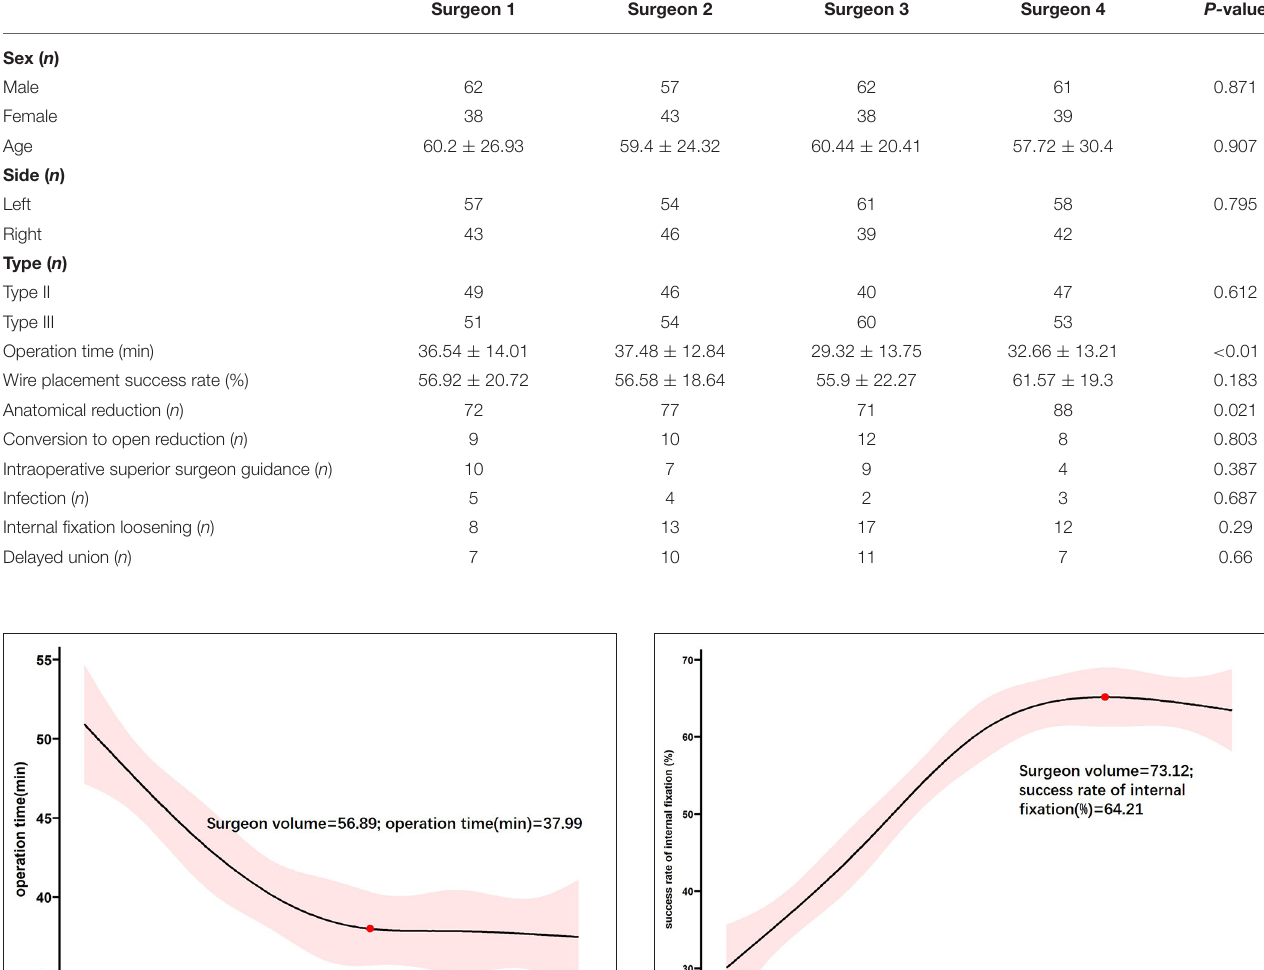
TABLE 3 | Patient characteristics for each surgeon. Surgeon 1 Surgeon 2 Surgeon 3 Surgeon 4 P- value